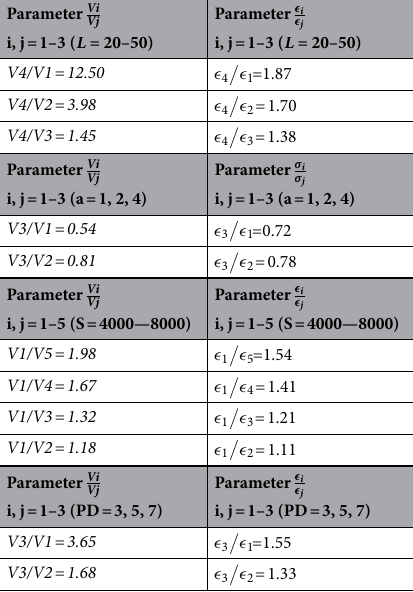
Table 3. Ratio of average velocity and strain of polymer chain for different polymer beads number, repulsive, harmonic bonding and density